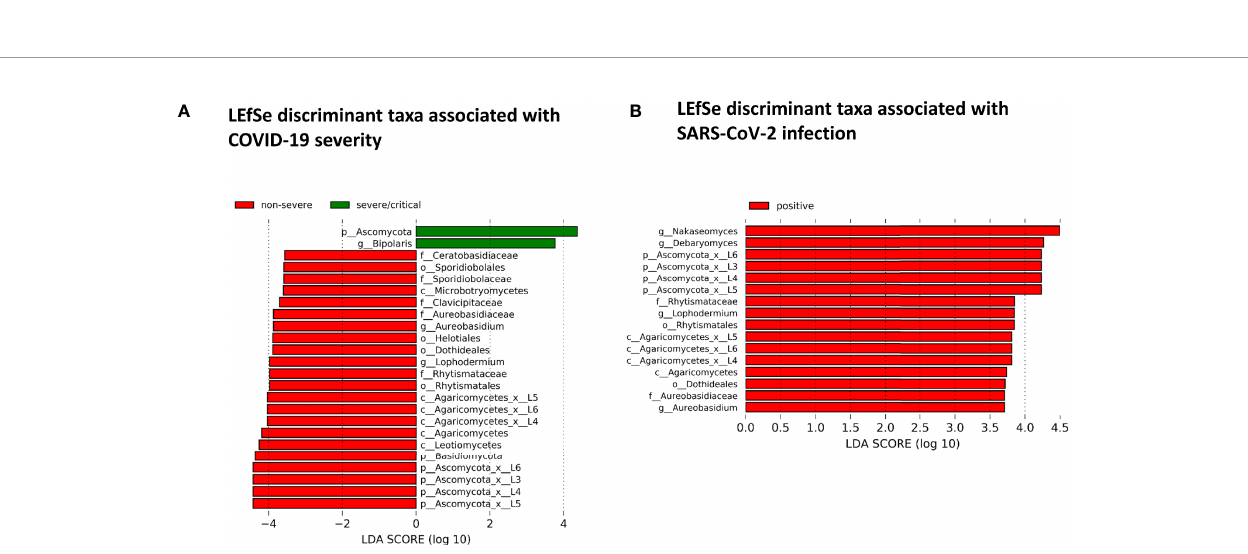
FIGURE 4 | (A) Linear discriminant effect size (LEfSe) analysis for identi fi cation of fungal taxa enriched in severe/critical COVID19 (green) or non-severe COVID-19 (red). (B) LEfSe for identi fi cation of fungal taxa enriched in SARS-CoV-2 positive (red) or SARS-CoV-2 negative patients with a minimum linear discriminant abundance value of 3.5